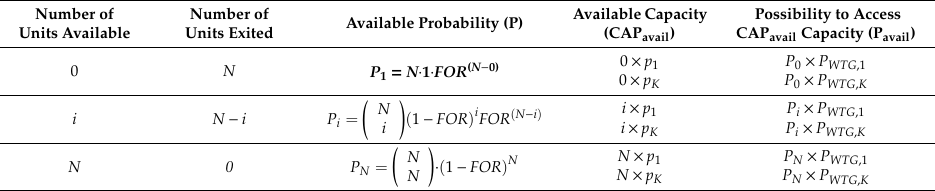
Table 3. The process of obtaining an output model for a wind farm.